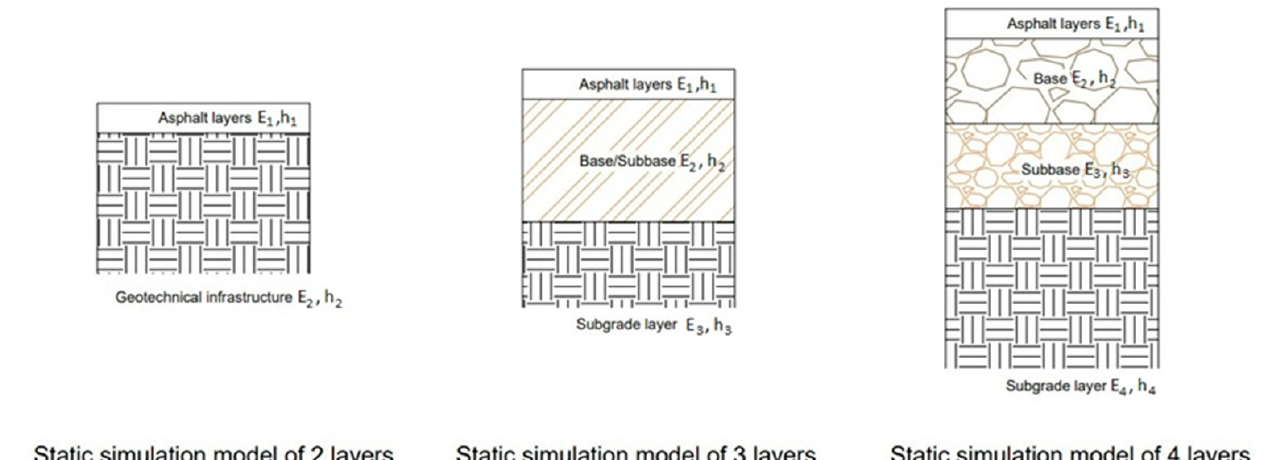
Figure 3. Static simulation models for flexible pavement structure.